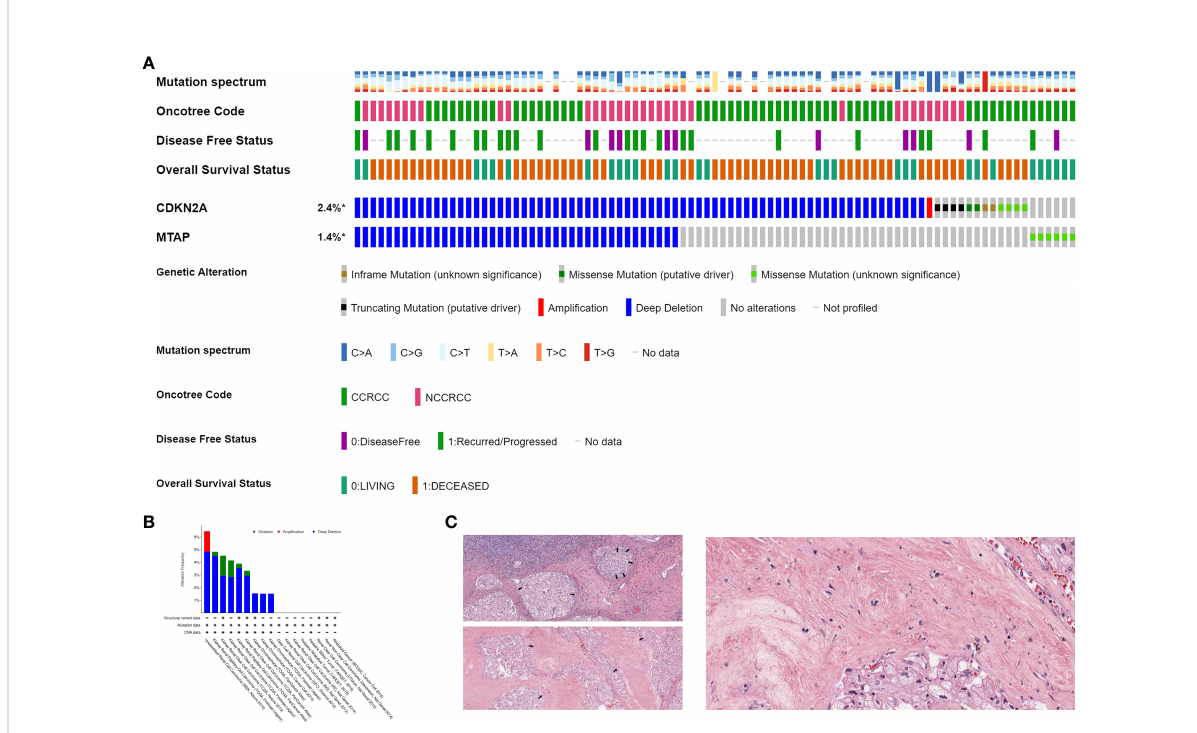
FIGURE 2 MTAP / CDKN2A MUT in histopathological subtypes and sarcomatoid differentiation of 3,563 patients with RCC from the Western cohort. (A) Relationship between MTAP / CDKN2A MUT and histopathological subtypes of RCC, disease-free status, and OS status in 3,563 RCC samples from the Western cohort. (B) The frequency of MTAP / CDKN2A genomic alterations in different RCC datasets. (C) Remarkable sarcomatoid differentiation in patients with both MTAP MUT and CDKN2A MUT from The Cancer Genome Atlas. * Ratio is calculated as altered/pro fi